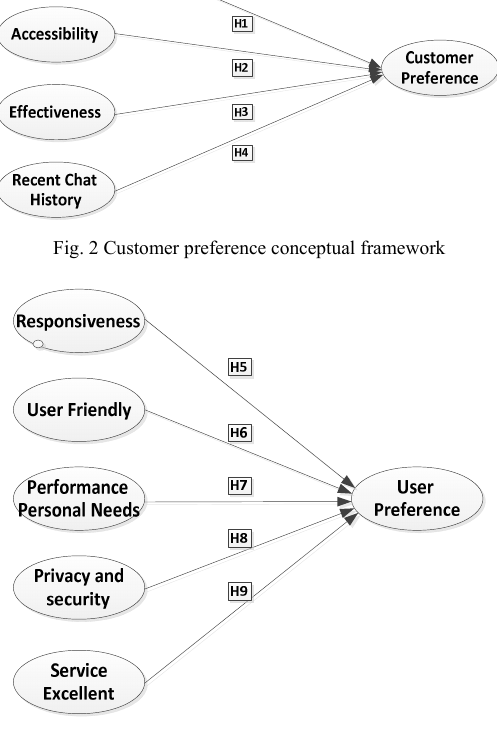
Fig. 3 User preference conceptual